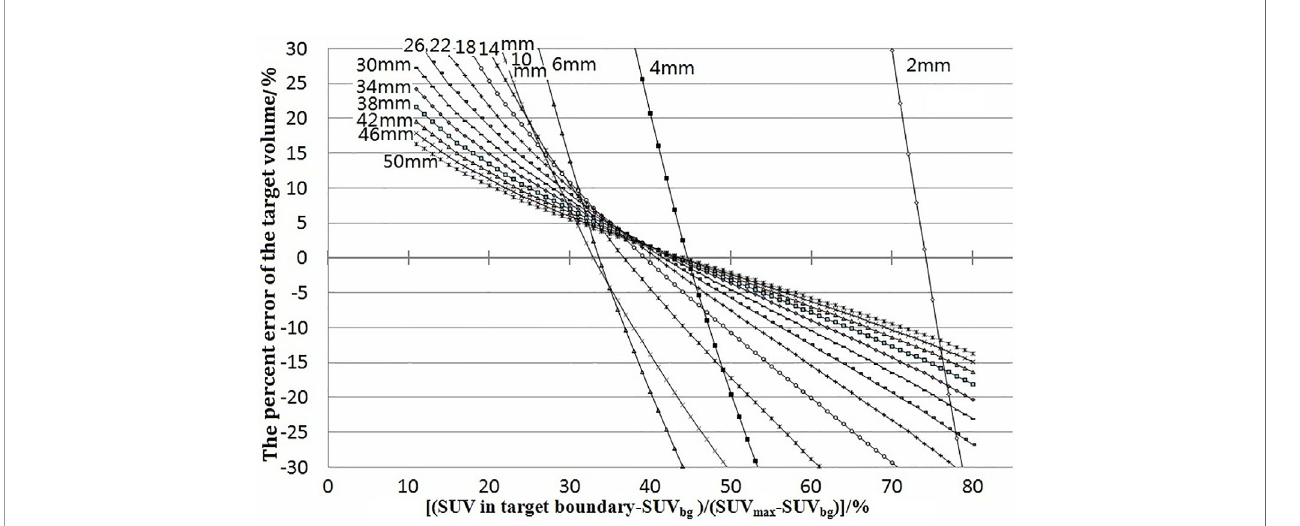
FIGURE 1 | Percent errors of the target volume [(target volume − real volume)/real volume] were plotted against (SUV in target boundary − SUV bg )/(SUV max − SUV bg ). The junctions of curves with 0 error were the thresholds. They showed the error and how the threshold varied with tumor size. The labels 2 – 50 mm beside the curves were the diameters of the